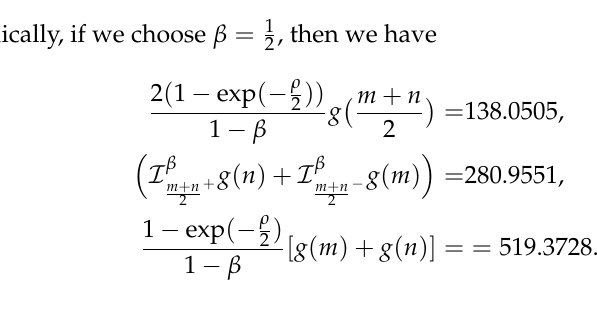
Figure 1. The image description of Corollary 2 for h ( t ) = t and g ( ξ ) = e 2 ξ